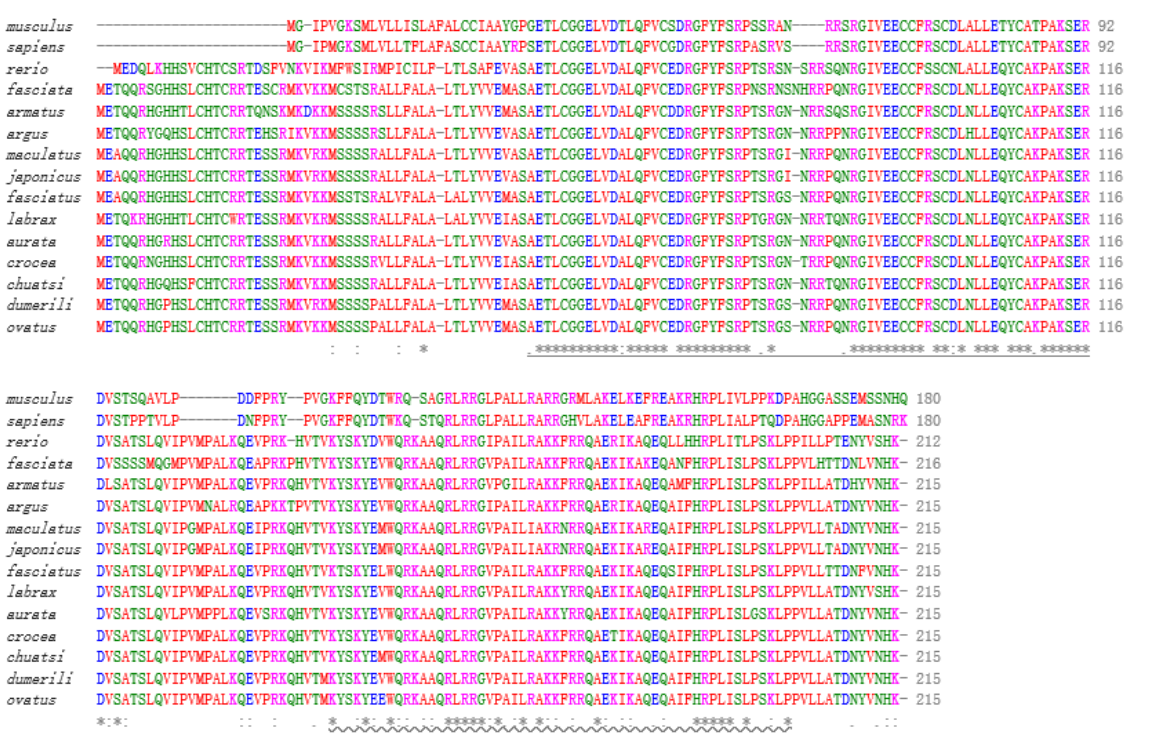
Figure 2. Structure of the genome sequence of igf2 . The black straight line represents a noncoding region. Green boxes represent exons.